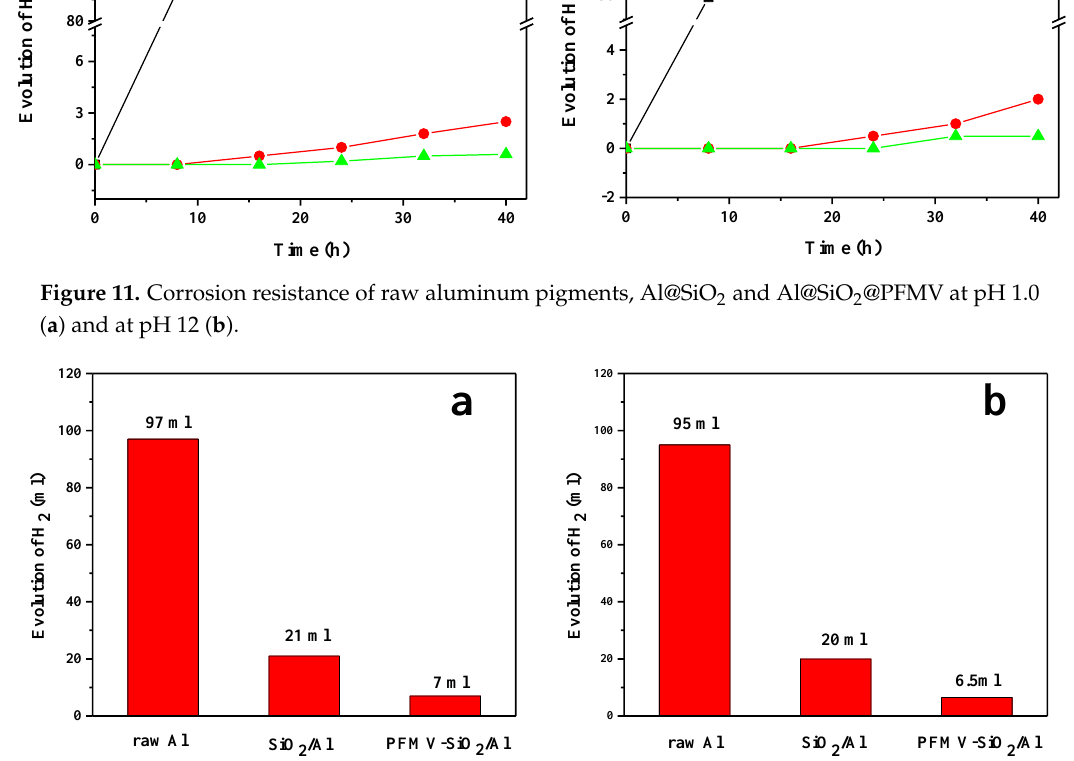
Figure 12. The volume of H 2 evolved from the raw aluminum pigments, Al@SiO 2 and Al@SiO 2 @PFMV pigments within 168 h at pH 1.0 ( a ) and at pH 12 ( b ).